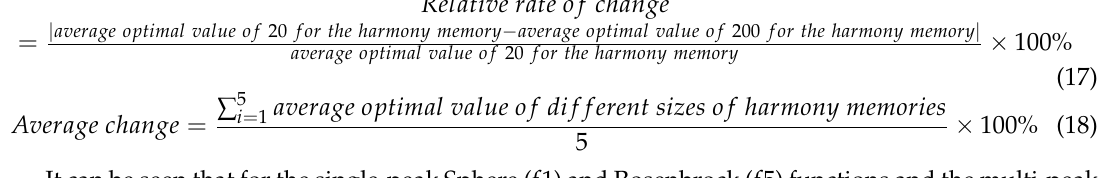
Figure 11. Comparison of the average optimum with different harmony memory sizes of the Rosenbrock function.